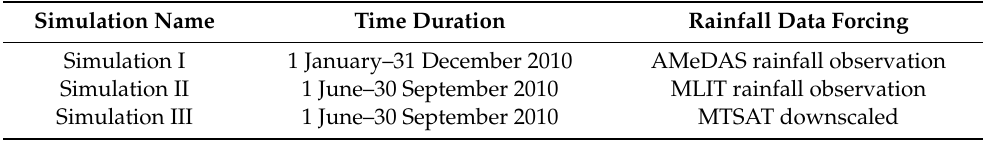
Table 2. Summary of river flow simulations using MATSIRO.